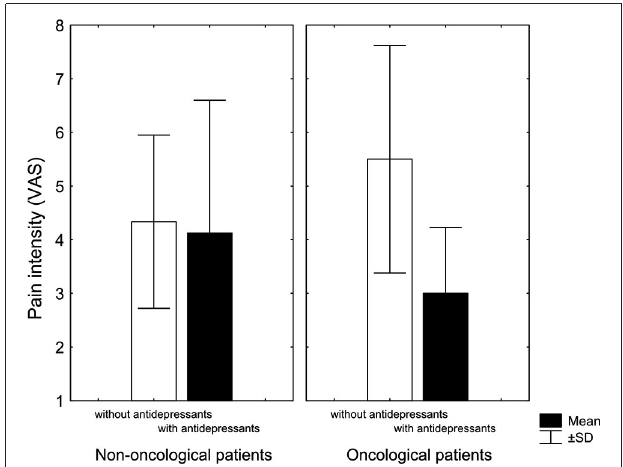
FIGURE 1 | Pain intensity (visual analogue scale) at the end of treatment of patients with chronic nonmalignant and malignant pain treated with antidepressants (black columns) and patients treated without antidepressants (white columns) . Antidepressants marginally reduced pain in cancer patients Kruskal-Wallis non-parametric test ( KW-H ( 1,11 ) = 2.9, p = 0.08; KW-H : Kruskal-Wallis non-parametric test) (Adopted from Rokyta et al., 2009).